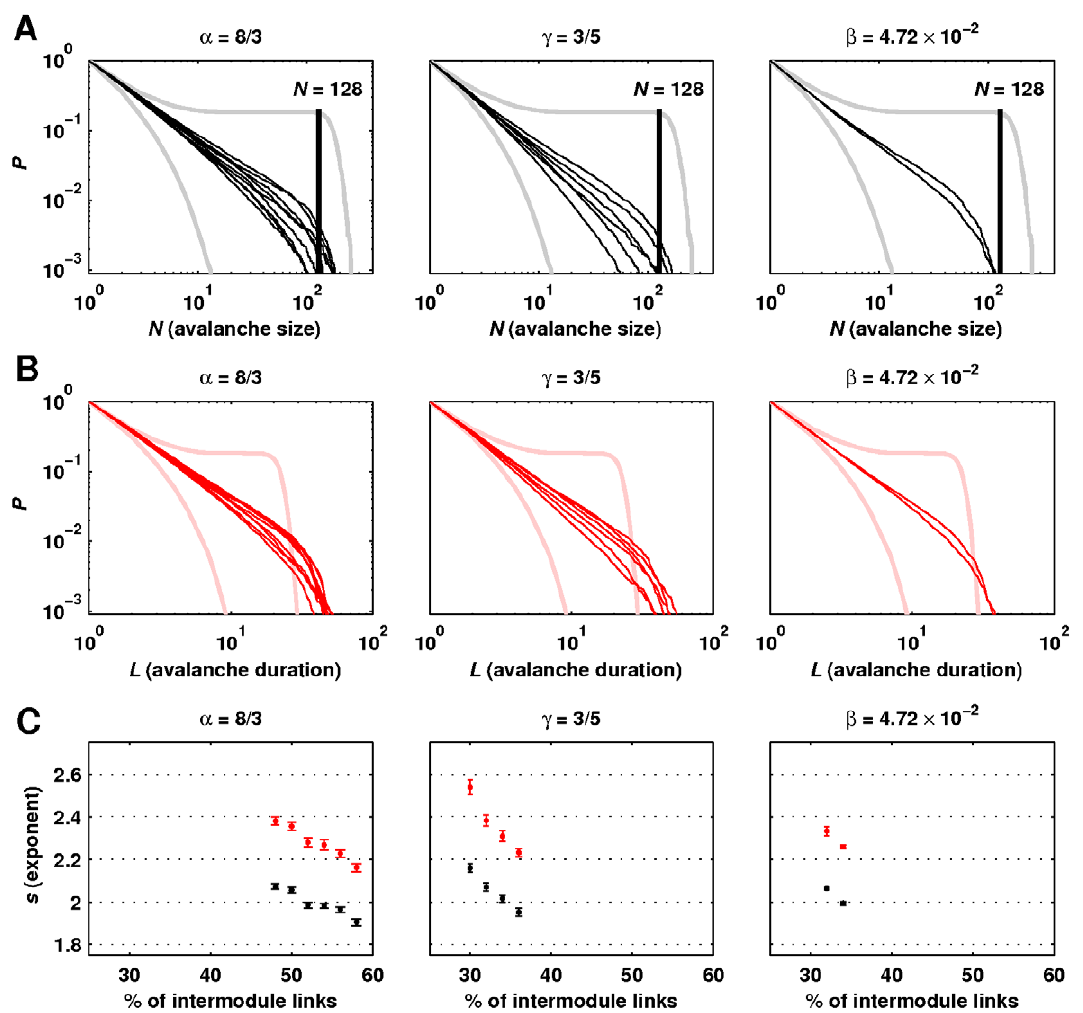
Figure 7. Illustrative power-law distributions of avalanche sizes and durations. Cumulative probability distributions of avalanche (a) sizes and (b) durations for the optimal power-law ( a ~ 8 = 3 ), exponential ( c ~ 4 = 5 ) and linear ( b ~ 4 : 72 | 10 { 2 ) density scaling functions. Gray and pink distributions correspond to random networks (concave distributions) and ordered networks (convex distributions). (c) Mean exponents of statistically significant power-law distributions of avalanche sizes (black) and durations (red), as a function of network randomization. Error bars represent the standard error of the mean from 20 simulations.